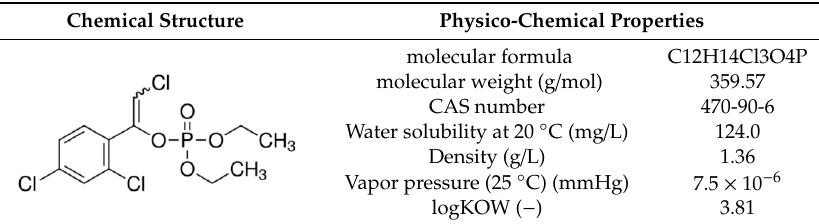
Table 1. Physico-chemical characteristics of chlorfenvinphos.